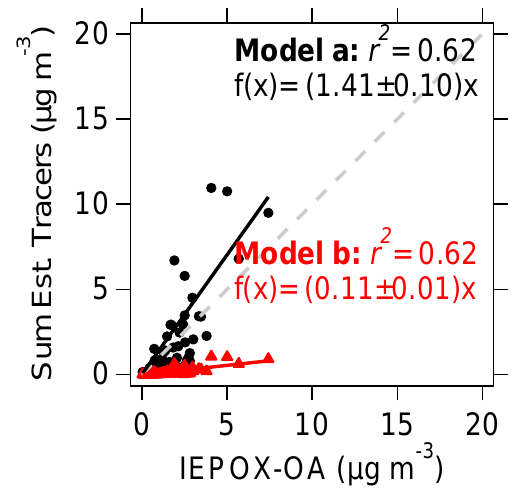
Figure 6. Correlation of summed IEPOX-derived SOA tracers es- timated by simpleGAMMA by assuming H ∗ of 3.0 × 10 7 (Nguyen et al., 2014) (model a) and 2.7 × 10 6 (Pye et al., 2013) (model b) and IEPOX-OA factor from PMF